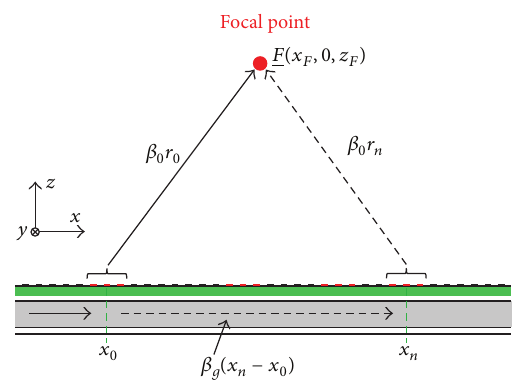
Figure 9: A nonuniform periodic scatterer (in red) radiates a portion of the guided wave with a location-dependent phase delay. The scattered waves build up constructive interference at the target